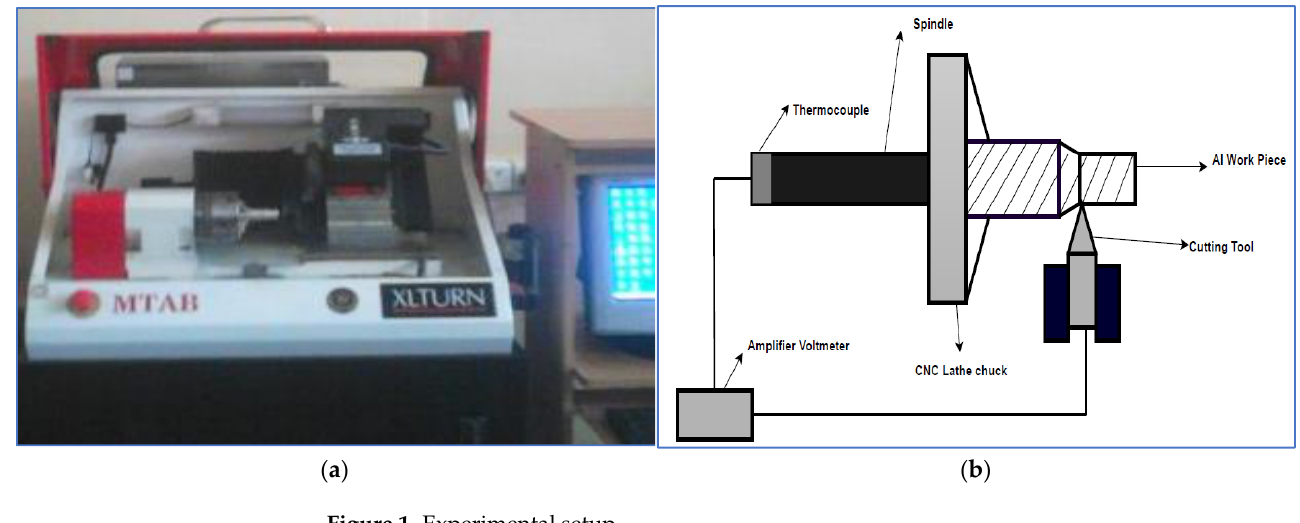
Figure 1. Experimental setup.